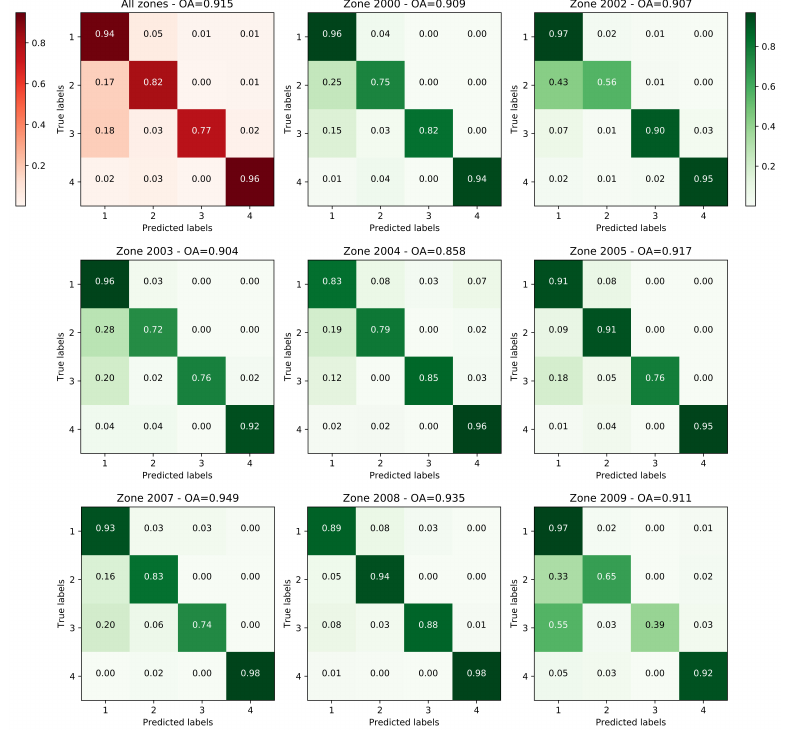
Figure 12. Normalized confusion matrices for the area-base validation of the RF riverscape units map, zone by zone and global assessment. Corresponding class codes are reported in Table